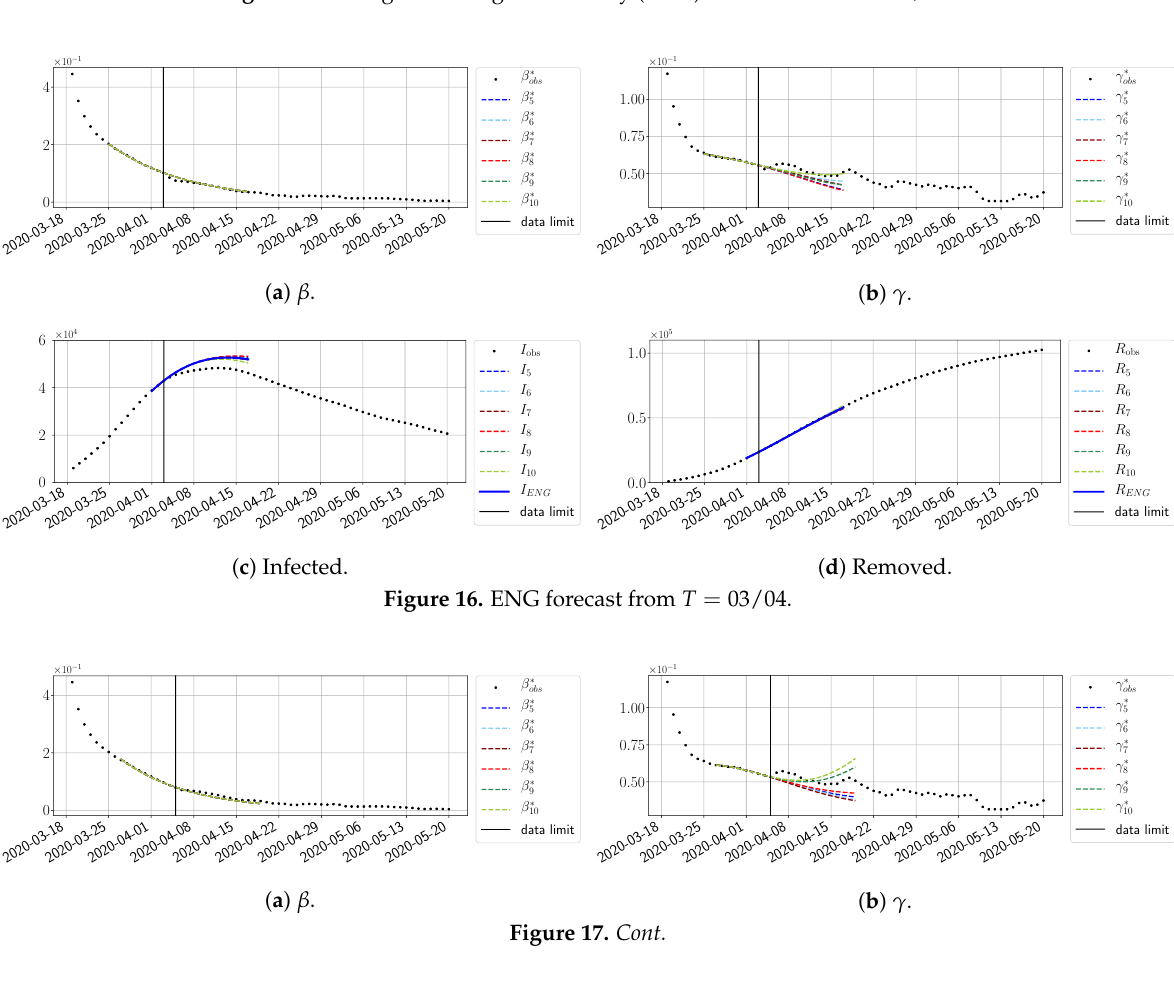
Figure 15. Enlarged Nonnegative Greedy (ENG) forecast from T = 01/04.